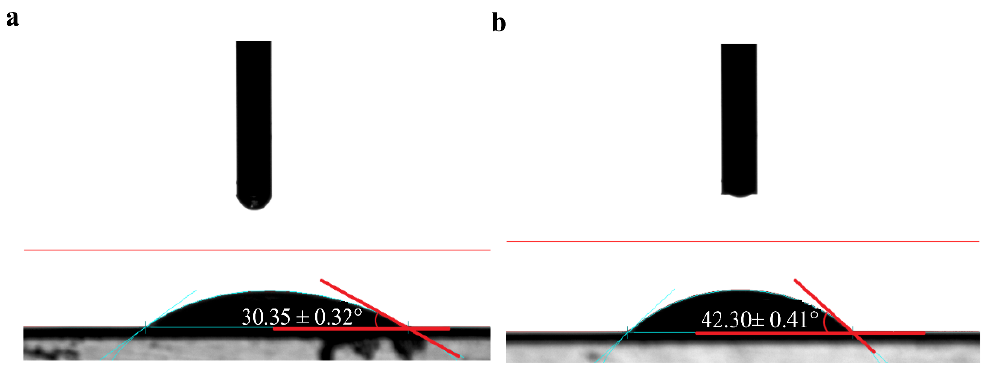
Figure 3. Change in contact angle. ( a ) pristine membrane; ( b ) fouled membrane.